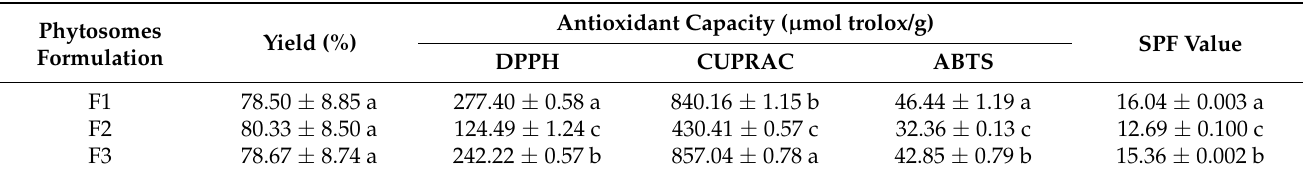
Different letters indicate a significant difference ( p < 0.05) according to Duncan’s multiple range